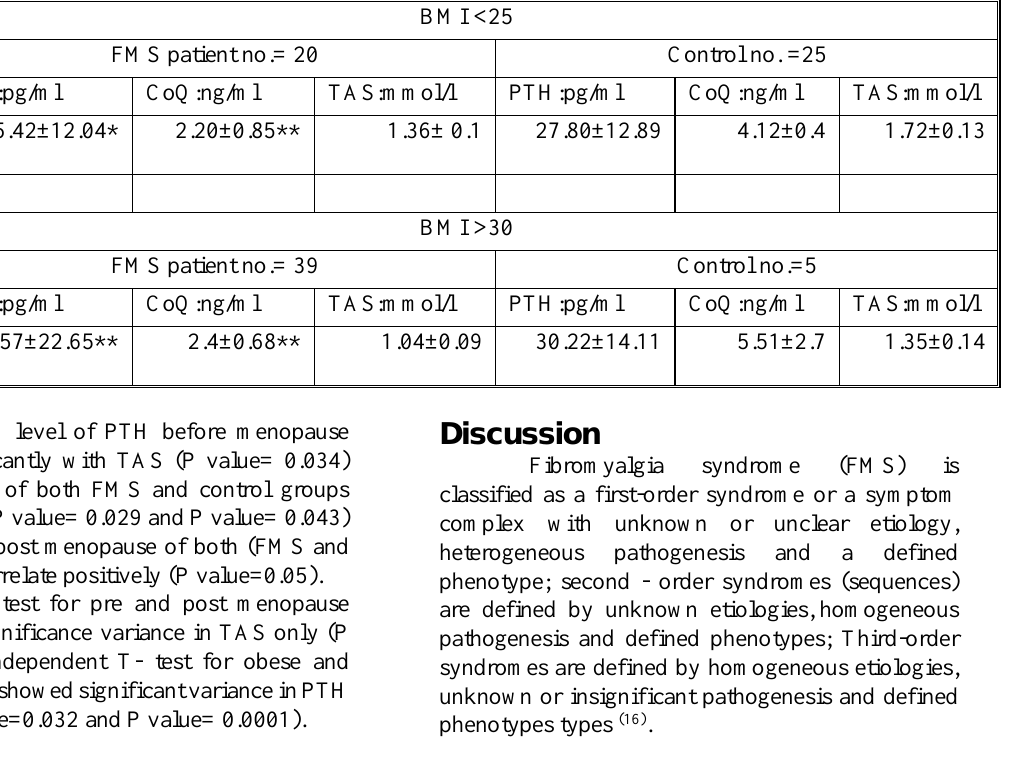
Table 3.The serum level of biochemical markers (mean± SD) in FMS and control distributed according to their